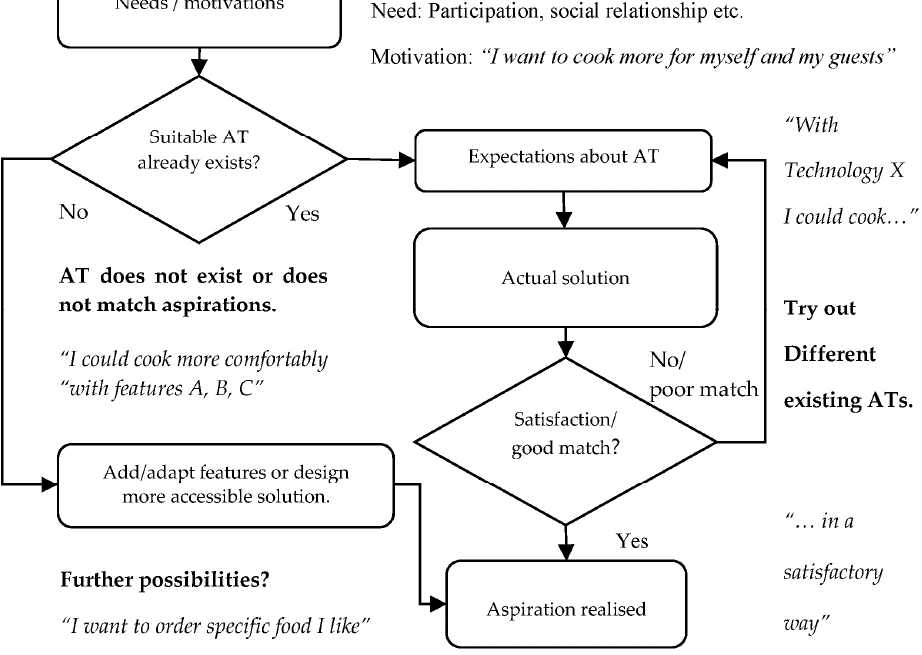
Figure 1. Model of aspiration-led evaluation and design, with meal-making used as an example.